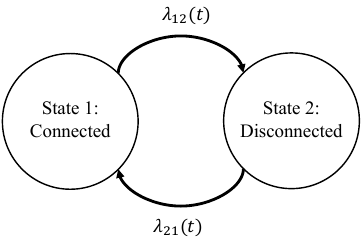
Figure 4. Charging states